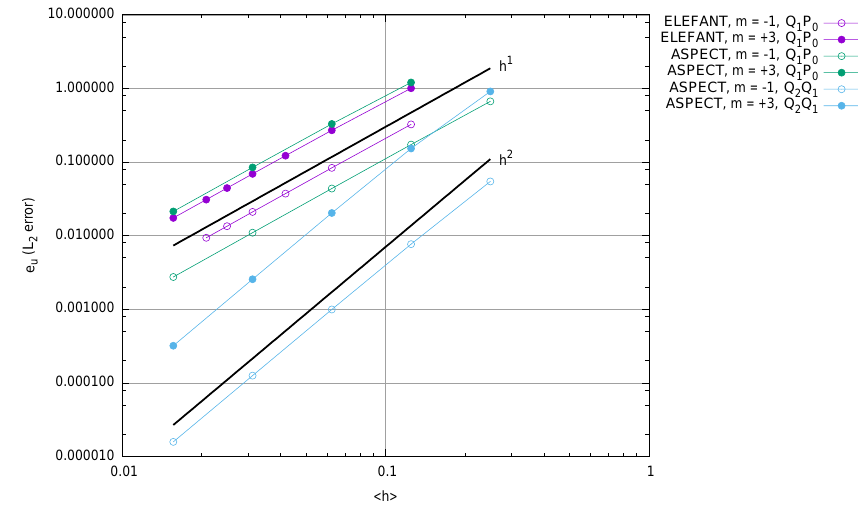
Figure 4. Velocity L 2 -norm error vs. average resolution for ELEFANT and ASPECT.